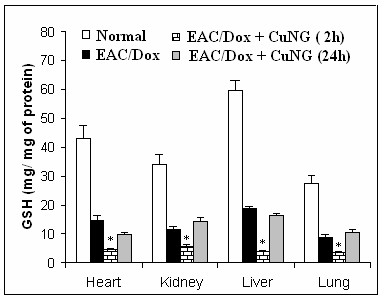
Effect of in vivo CuNG treatment on GSH levels 2 h and 24 h post-treatment in heart, kidney, liver and lung of EAC/Dox bearing mice. Results are compared with corresponding controls. Results presented as mean ± S.D. of 3 independent experiments, each involving 5 animals in each experimental group. GSH levels decreased significantly in all organs 2 h following CuNG treatment in vivo in EAC/Dox bearing animals compared to their untreated counterparts (*, P < 0.01).